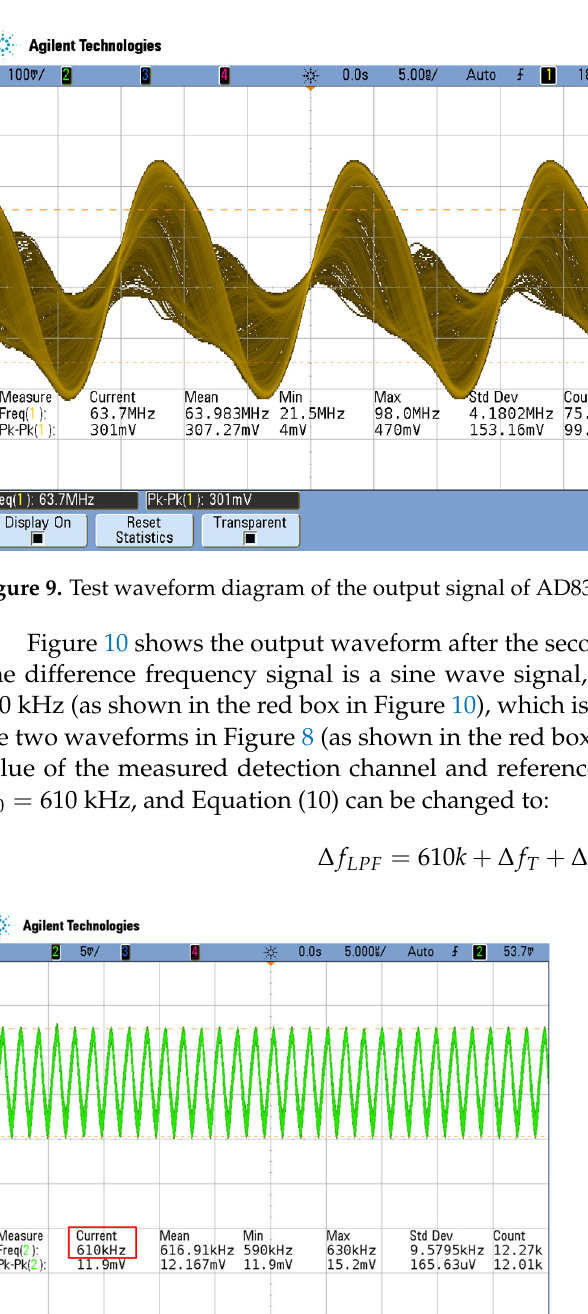
Figure 10. Test waveform diagram of differential frequency signal of low-pass filter .